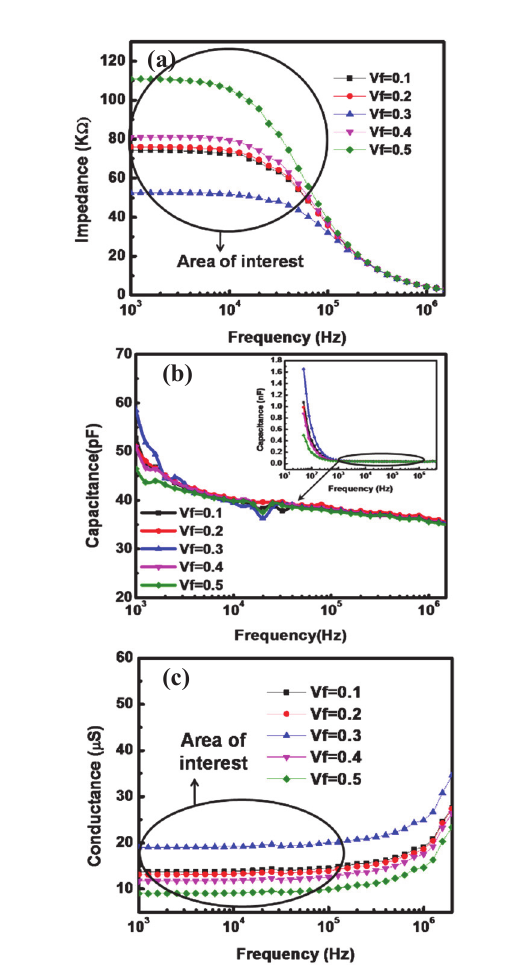
Fig. 6: Plots showing the experimentally measured spectra of impedance, capacitance and conductance for different compositional concentration of glucose in DI water. (a) Impedance over the frequency window emphasizing 1 kHz to 100 kHz range. (b) Capacitance over the entire frequency window (inset) and Capacitance spectrum emphasizing 1 kHz to 1.5 MHz range (c) Conductance over the frequency window emphasizing 1 kHz to 100 kHz